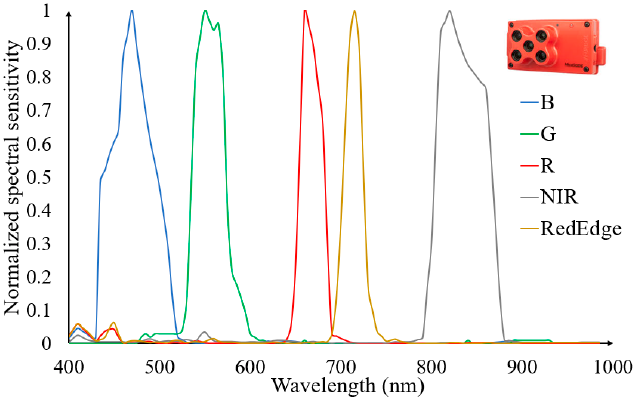
Figure 2. Spectral response curves of MicaSense RedEdge 3.